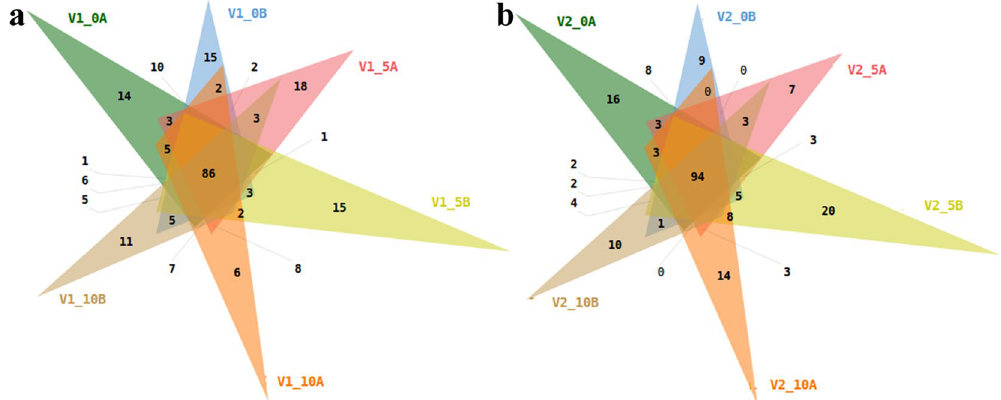
Figure 3. Distribution of common and known miRNAs in a Venn diagram of apical and basal spikelets of V1 (SR-159, a ) and V2 (SR-157, b ) during post anthesis (0, 5 and 10 days) in 12 samples based on homology against miRNAs of Oryza sativa genome using miRbase-21 database and